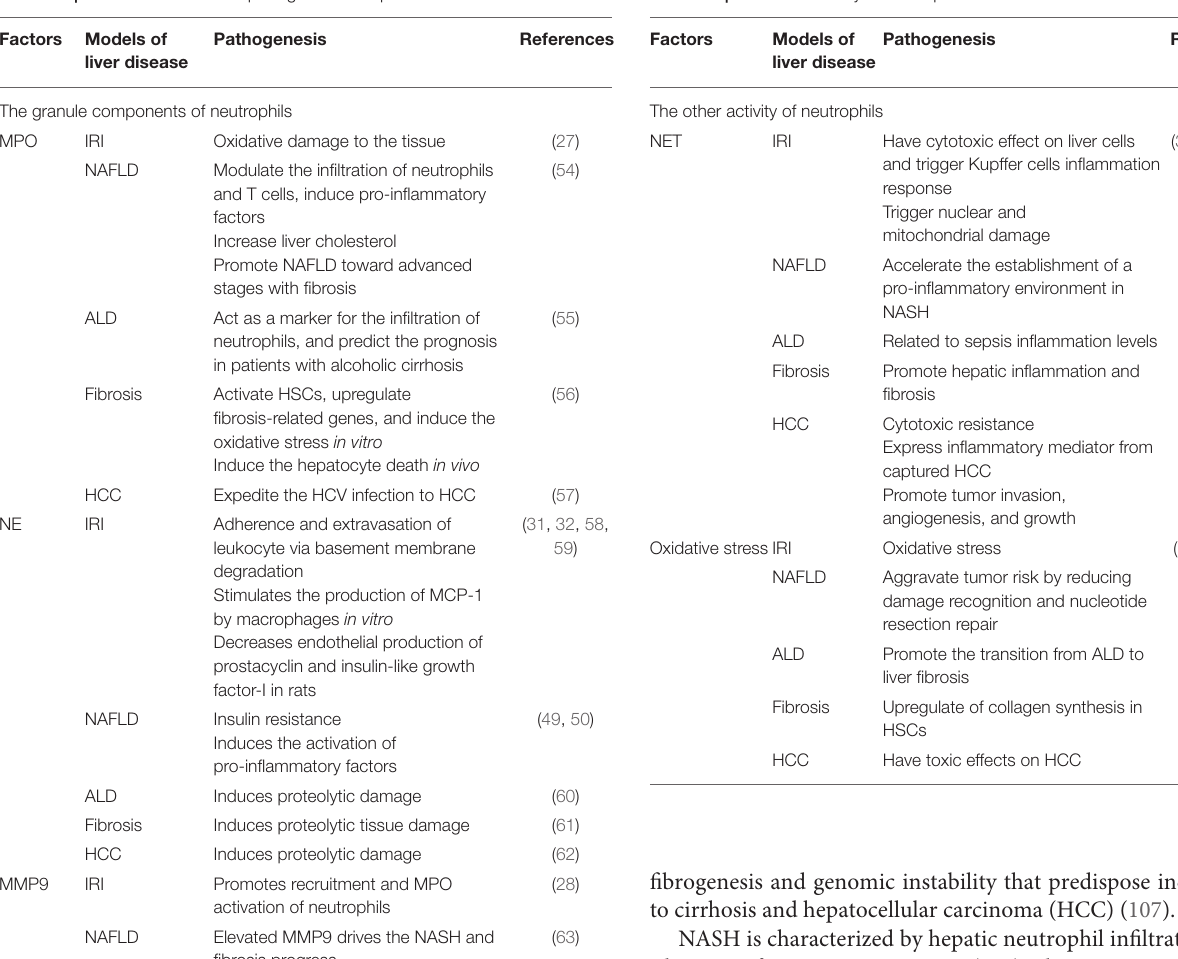
TABLE 2 | The function of neutrophils granule component in liver disease. TABLE 3 | The other activity of neutrophils in liver